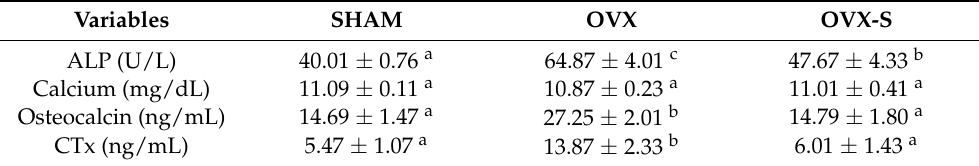
Table 3. Changes in biochemical markers of bone metabolism levels of Superjami rice bran extract supplementation diet in ovariectomized rats.